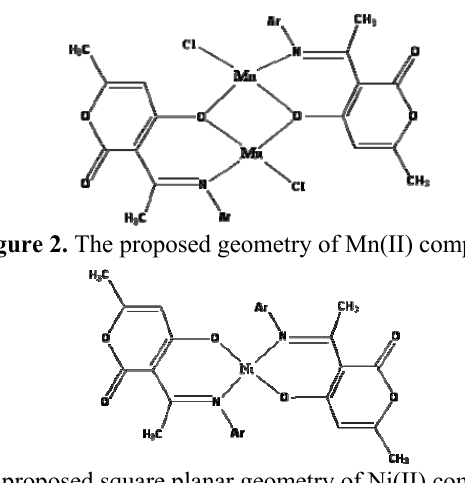
Figure 1. The proposed geometry of Cu(II), Co(II), Fe(III) Complexes